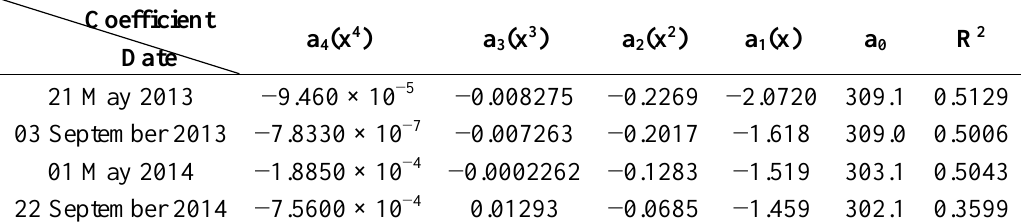
Table 4. The coefficient of polynomial fitting.